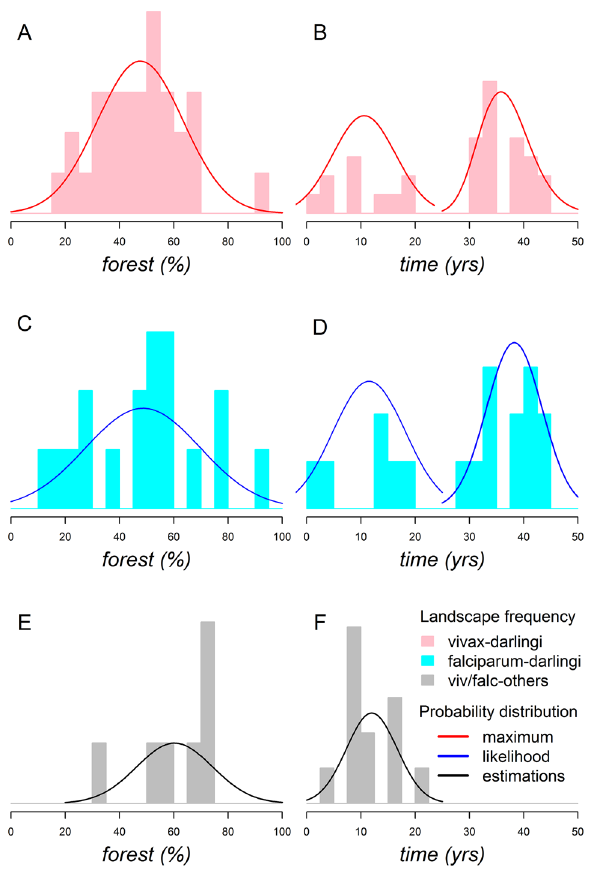
Figure 2. Site frequency of Plasmodium -infected anophelines along gradients of forest cover and time. ( A ) P . vivax - Ny . darlingi occurrence peaked in sites where the percentage of forest cover was intermediate (~ 50%). The maximum likelihood probability curve was estimated as a Gaussian distribution (mean = 47.64, sd = 15.86; p < 0.001). ( B ) P . vivax - Ny . darlingi occurrence showed two deforestation timeline peaks at (1) ~ 10 years (Gaussian distribution; mean = 10.6, sd = 5.77; p < 0.001) and (2) ~ 35 years (Log-normal distribution; meanlog = 3.59, sdlog = 0.13; p < 0.001) from the start of deforestation for the establishment of human settlements. The deforestation timeline distributions are significantly different (t = 12, df = 15, p < 0.001). ( C ) P . falciparum - Ny . darlingi occurrence was higher in sites with intermediate levels of forest cover (~ 50%) (Gaussian distribution; mean = 48.64, sd = 21.12; p < 0.001). ( D ) The deforestation timeline curves for the occurrence of infected mosquitoes were observed at (1) ~ 10 years (Gaussian distribution; mean = 11.5, sd = 6.65; p < 0.001) and (2) ~ 40 years (Gaussian distribution; mean = 38.25, sd = 5.1; p < 0.001). The deforestation timeline distributions were significantly different (t = 8, df = 8, p < 0.001). ( E ), P . falciparum and/or P . vivax occurrence in other Anophelinae species was higher in sites with forest cover of ≥ 60% (Gaussian distribution; mean = 60.28, sd = 14; p < 0.001). ( F ), A deforestation timeline peak at 12 years from the beginning of human occupation (Gaussian distribution; mean = 12, sd = 4.67; p < 0.001).